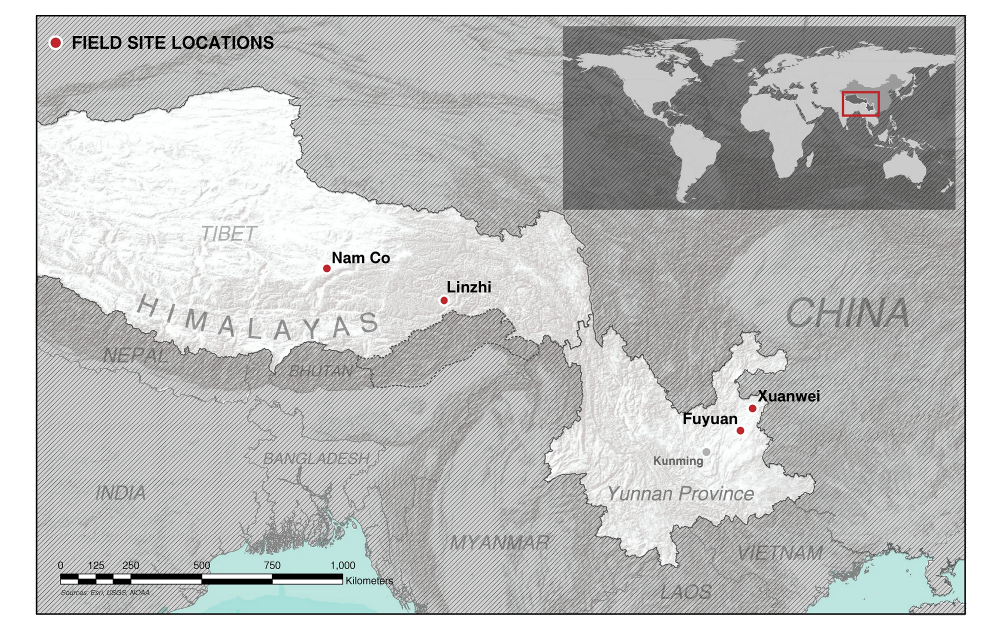
Figure 1. The geographical location of our field